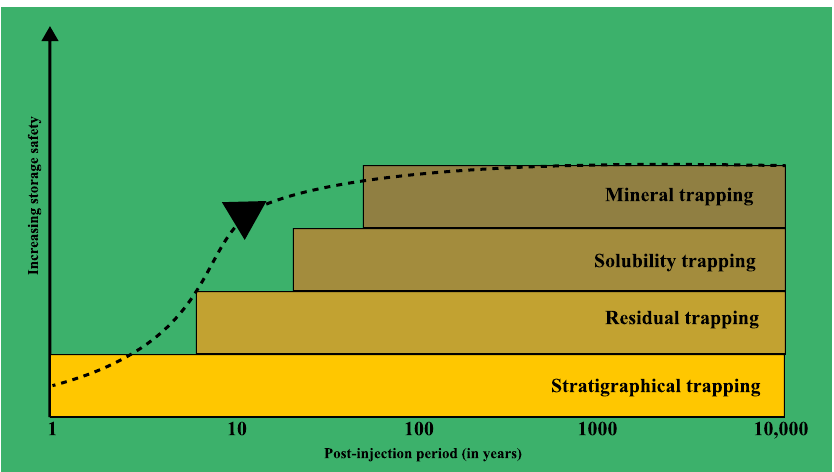
Figure 5. The time scale of CO 2 storage